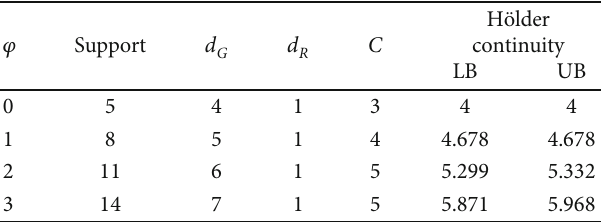
Table 2: Support, degree of polynomial generation ( d polynomial reproduction ( d -scheme for φ = 0, 1, 2 , and 3